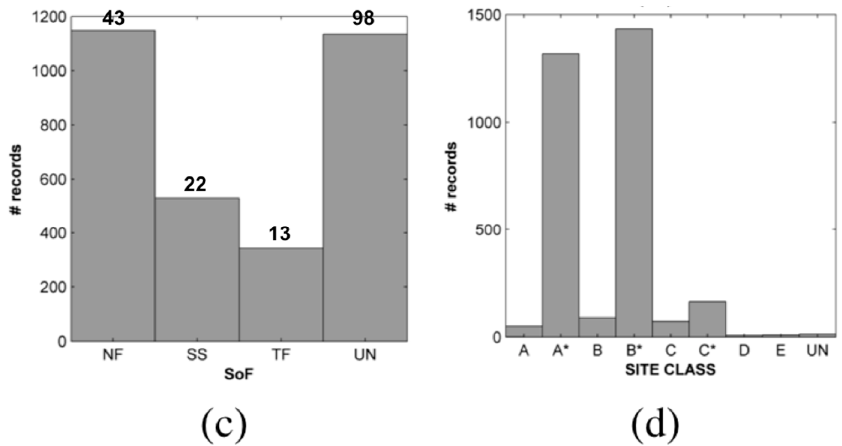
Figure 6. Number of records according to epicentral distance ( a ); Magnitude range (M W or M L ) ( b ); Focal mechanisms (NF, normal fault; SS, strike-slip fault; TF, thrust fault; UN, undefined mechanism) ( c ); and soil categories ( d ) (*, EC8 classes inferred from surface geology instead of V S,30 ). The number of records for magnitude and style of faulting classes are also indicated.